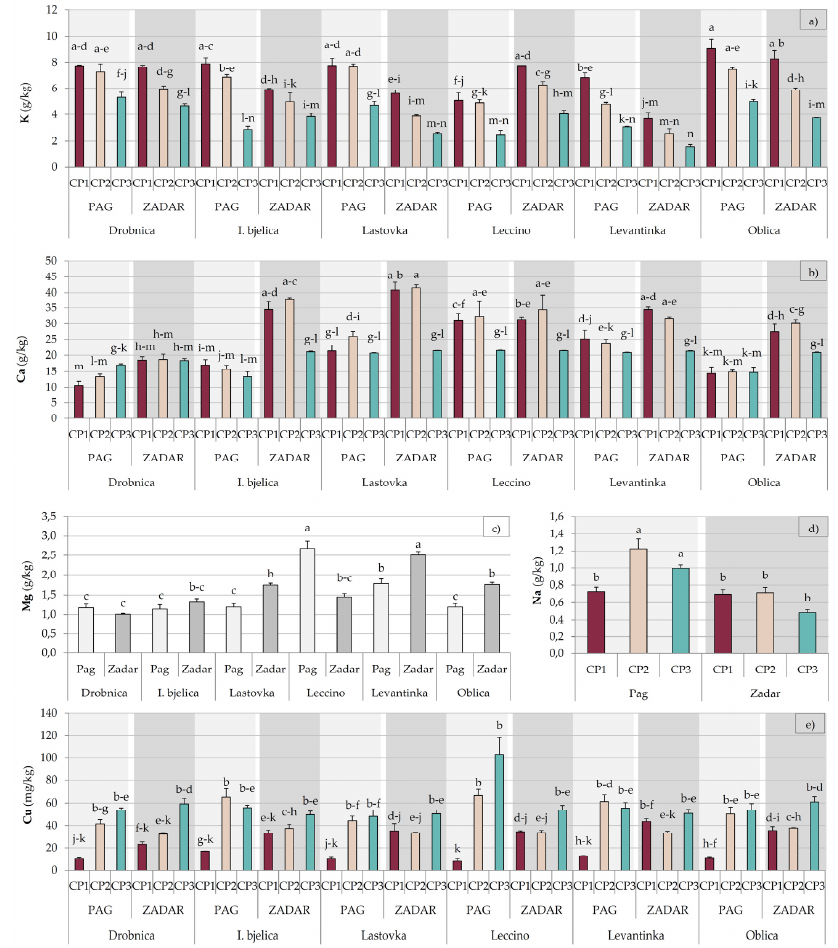
Figure 2. Multiple comparisons of the effects of cultivar, collection period, and location combinations (highest order interactions) on the concentrations of ( a ) potassium (K), ( b ) calcium (Ca), ( c ) magnesium (Mg), ( d ) sodium (Na), and ( e ) copper (Cu) concentrations in leaves of Drobnica, Istarska bjelica (I. bjelica), Lastovka, Leccino, Levantinka, and Oblica olive cultivars collected at different periods (CP1—October 2017, CP2—January 2018, and CP3—March 2018) in two different locations (Pag and Zadar) in Croatia (burgundy, beige, and turquoise colors of histogram bars represent collecting periods CP1, CP2, and CP3, respectively, while lighter and darker gray colors (histogram bars and backgrounds) represent Pag and Zadar locations, respectively). Different superscript lowercase letters represent statistically significant differences between mean values at p < 0.05 obtained by a one-way ANOVA and Tukey’s test.